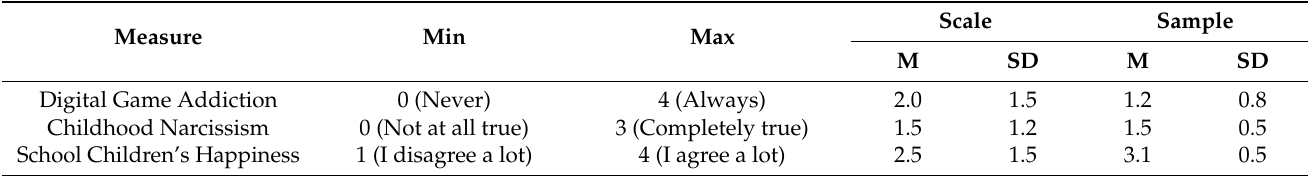
Table 2. Means and standard deviations of